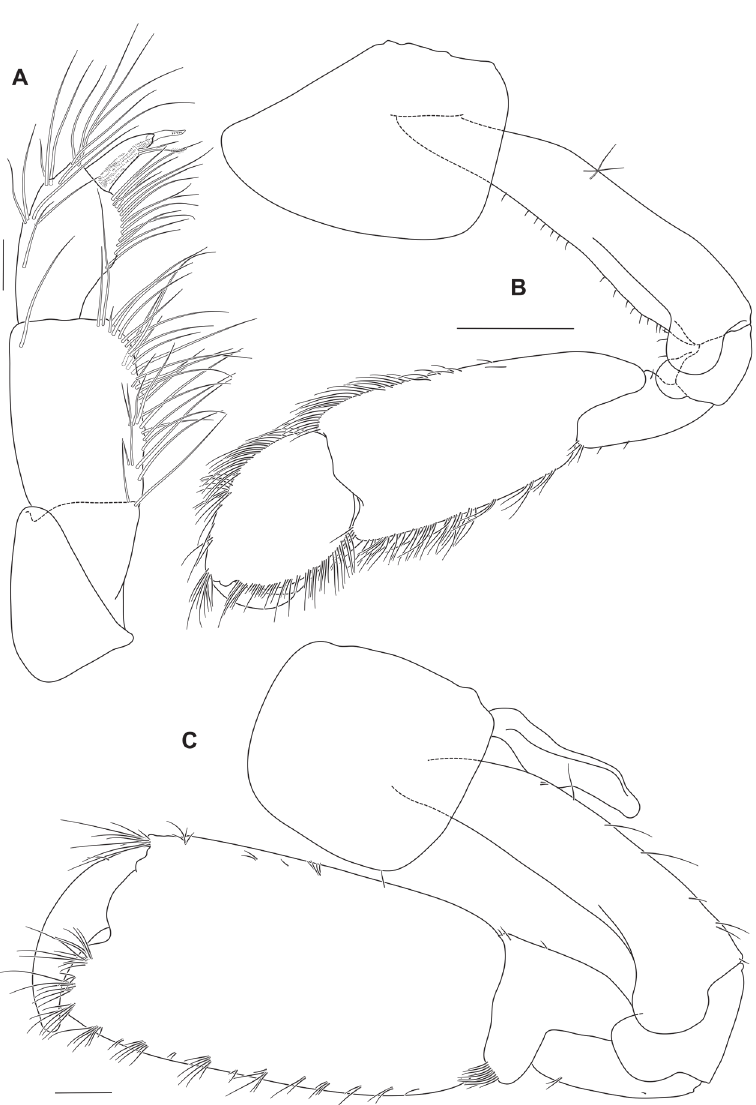
Figure 6. Ampithoe tarasovi Bulycheva, male holotype A palp of maxilliped B gnathopod 1 C gnathopod 2. Scale bars: 0.1 mm ( A ); 1 mm ( B ); 0.5 mm ( C ).